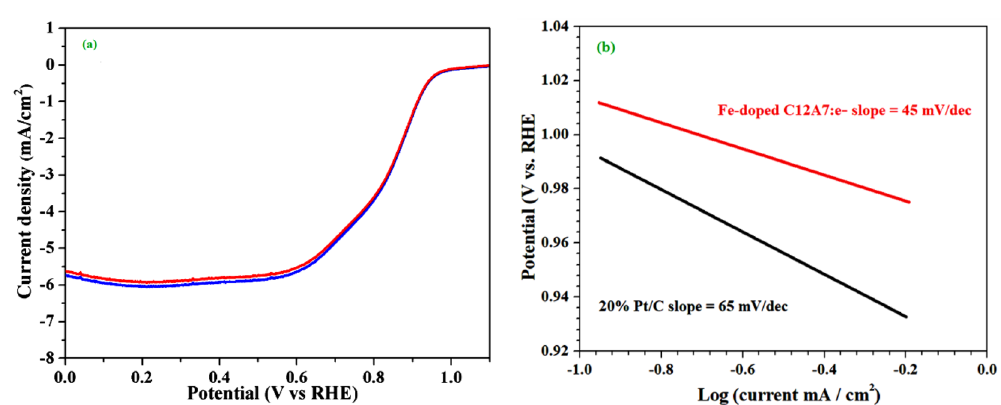
Figure 10. ( a ) LSV curves of the Fe-doped C12A7:e − composite in O 2 -saturated 0.1 M KOH without (blue curve) and with (red curve) 1 M MeOH, ( b ) Tafel plots calculated from the RDE polarization